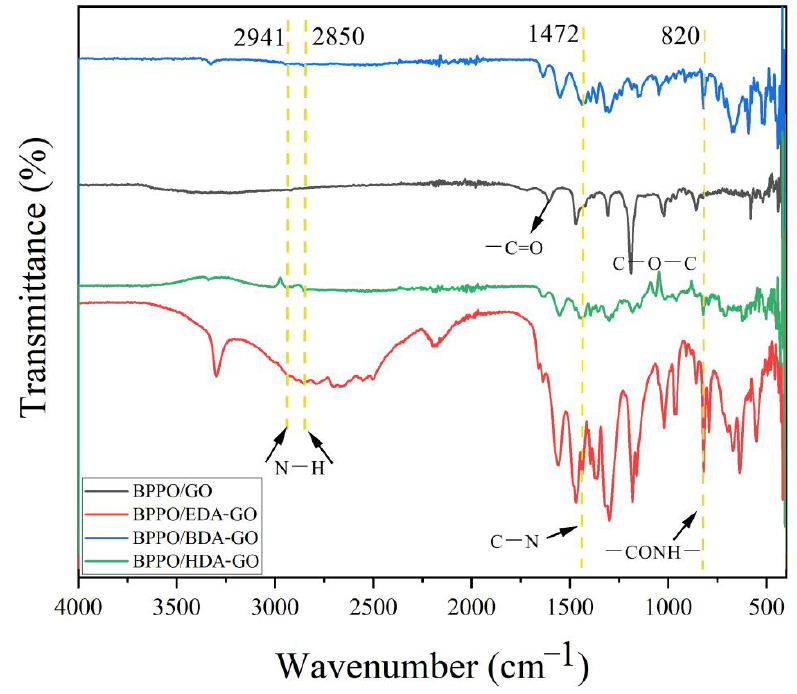
Figure 5. FTIR spectra of the BPPO/GO membrane and the Ax-GO-modified nanofiltration mem-